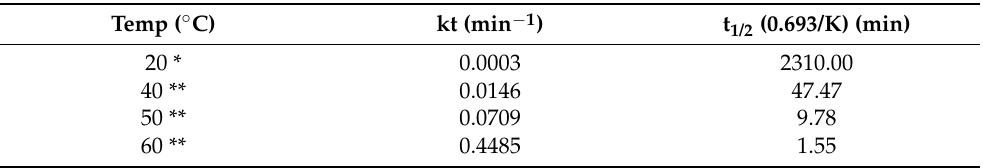
Table 3. Rate constant kt and t 1/2 values for CMS degradation in the presence of 0.5 M sulfuric acid at different temperatures (20 °C, 40 °C, 50 °C, and 60 °C), as calculated by Tenua. Temp (°C) kt (min − 1 ) t 1/2 (0.693/K) (min)